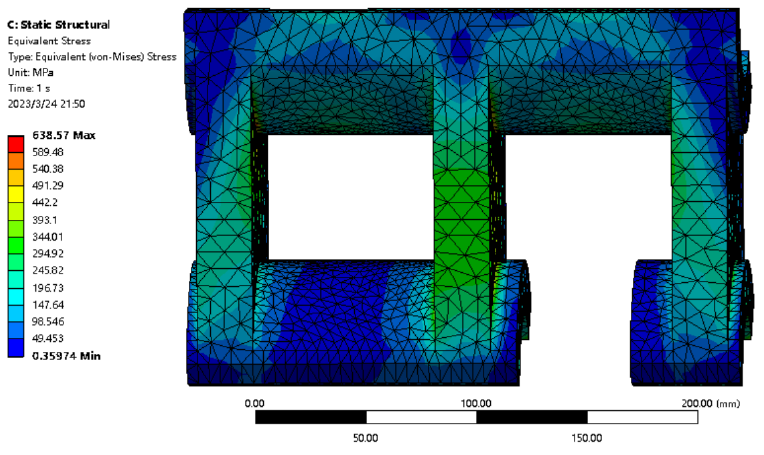
Figure 11. Stress of hollow drive rod.